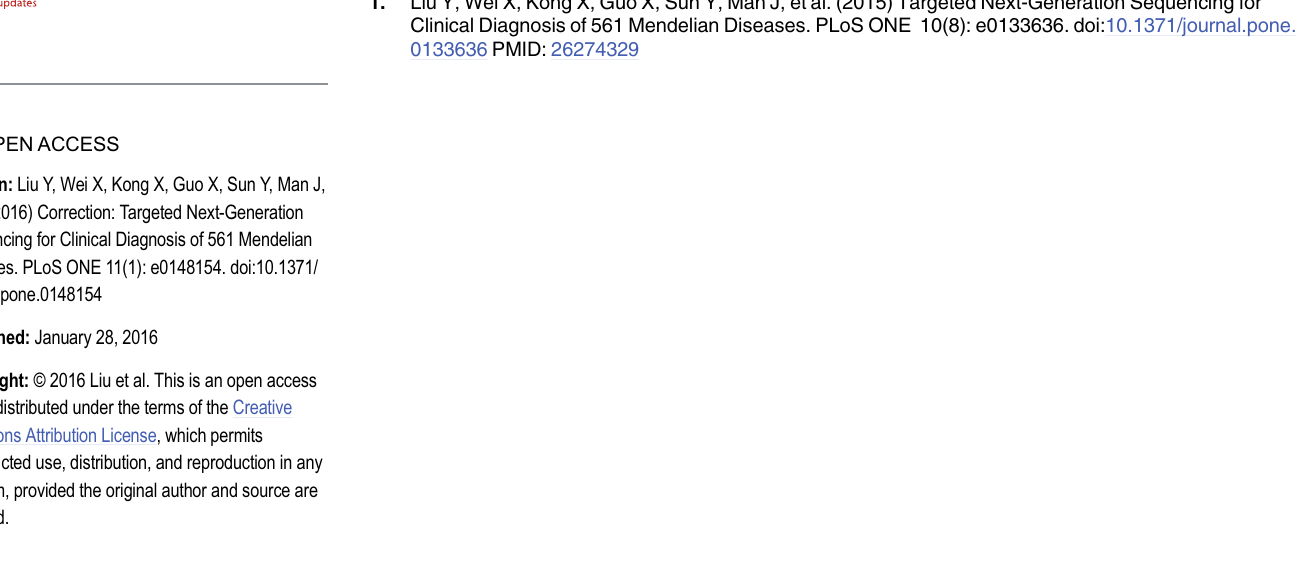
S3 Table. The list of 561 Mendelian diseases. S4 Table. Results of normalization analysis of three patients (P88, P89 and P90). We detected a microduplication of chromosome 10 in patient P88, the gender ratio was about 1.42. We detected a microduplication of chromosome 9 in patient P89, the gender ratio was about 1.31. We detected a microdeletion in chromosome 17 (16773072 – 20222149) in patient P90, the gender ration was about 0.55. S5 Table. Primer pairs designed for validation of mutations by Sanger sequencing or real- time